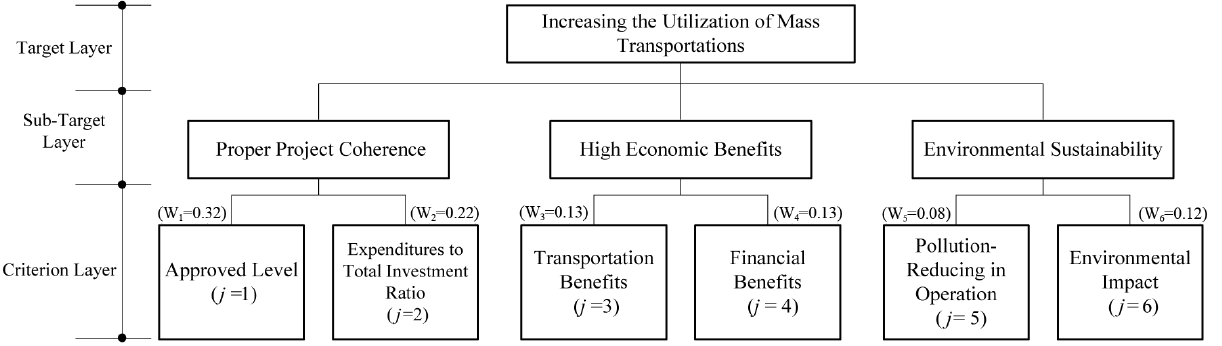
Fig. 1. Hierarchy structure and weights for ranking railroad construction